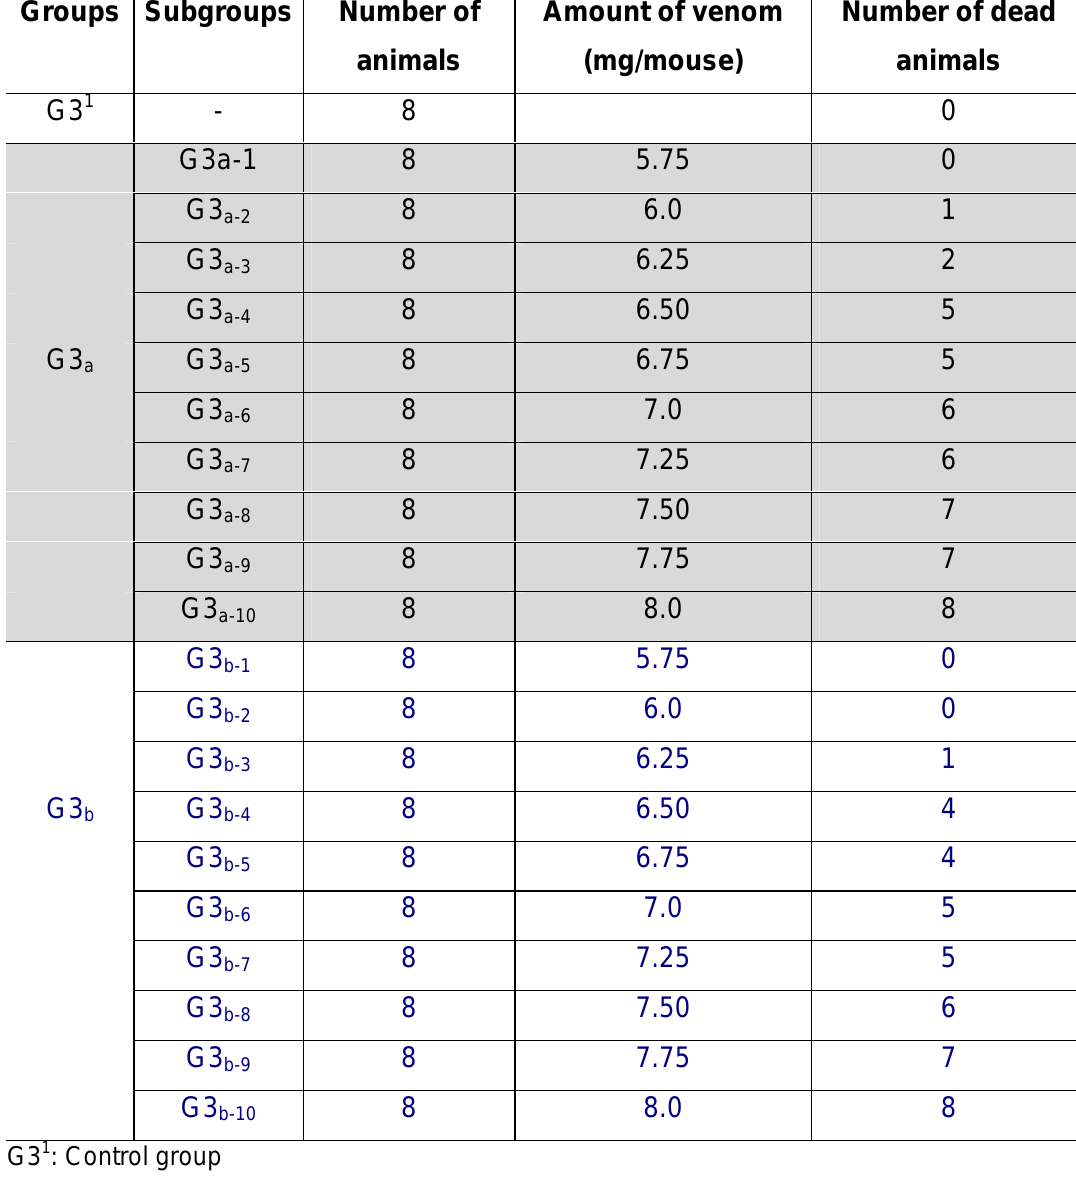
Table 2C: Number of animals in each subgroup, amount of venom used, and number of dead animals in Group 3 (injected with venom solution from telsons weighting from 10 to